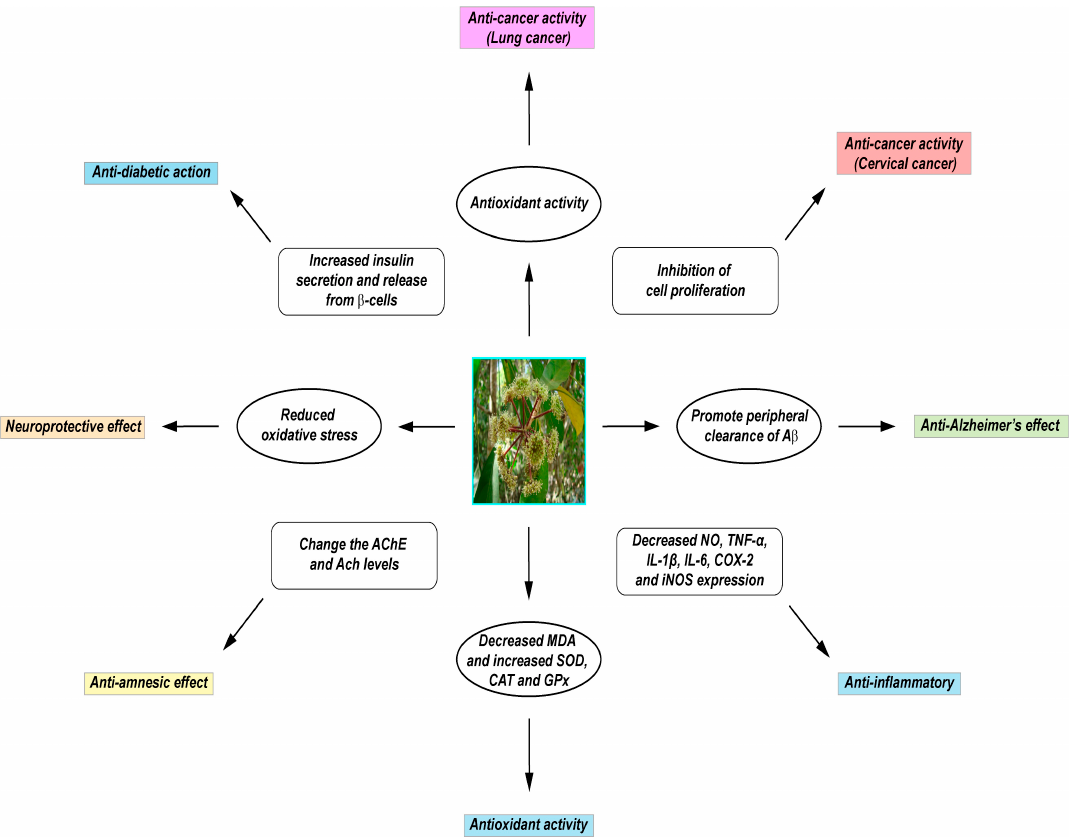
Figure 1. Pharmacological activities of D. Morbiferus .